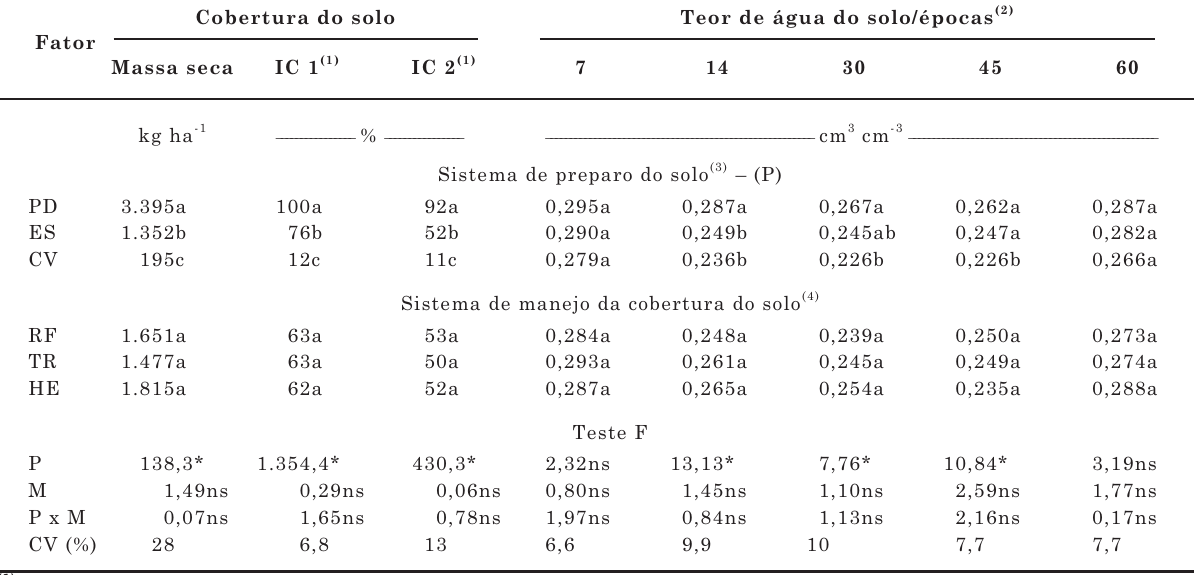
semeadura das culturas de inverno. (2) Época: determinação do teor de água do solo (camada de 0–10 cm), realizados aos 7, 14, 30, 45 e 60 dias após a emergência (DAE) de cobertura do solo. (3) PD: plantio direto, ES: escarificação (escarificador + rolo